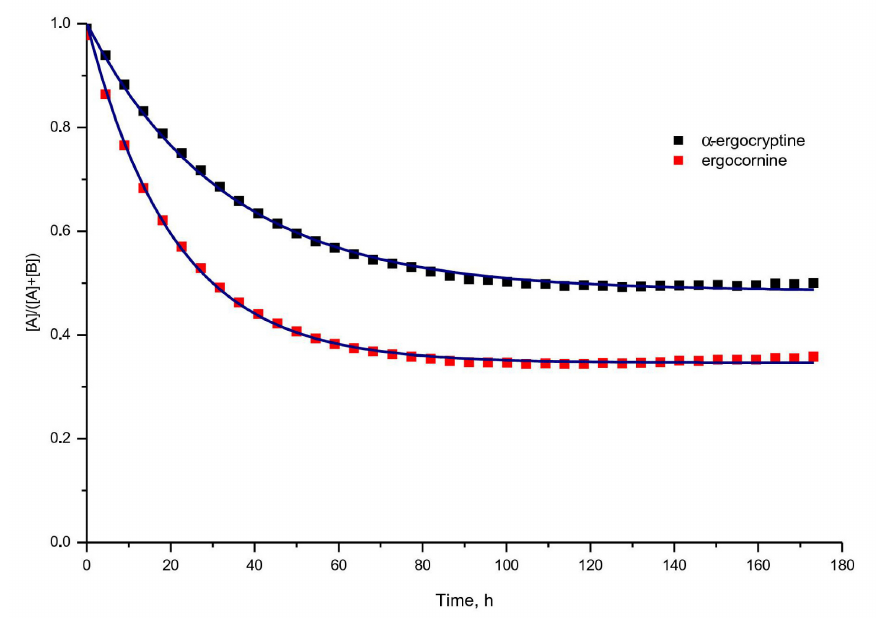
Figure 4. Change in ratio of R -epimer to sum of both epimers in a 1:4 (volume fraction) acetonitrile water mixture containing 10 mM ammonium